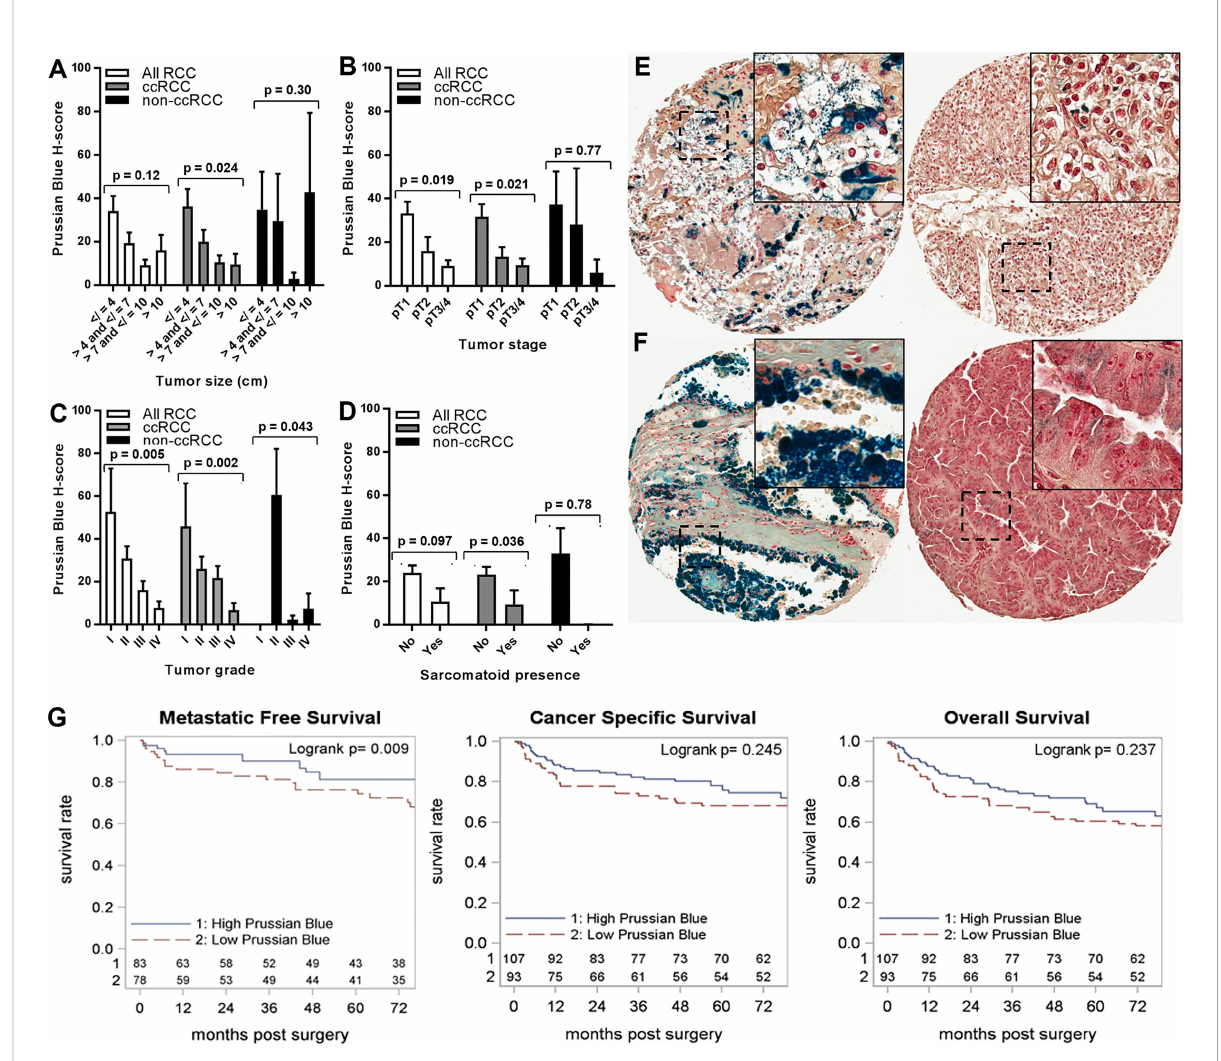
FIGURE 3 Iron levels in primary tumors decrease with tumor progression. Primary tumor iron levels (H-score) were evaluated using Prussian Blue stain of the RPCCC RCC patient TMA set and tested for association with pathologic features of primary tumors including (A) tumor size (largest diameter), (B) tumor stage, (C) tumor grade, and (D) presence of sarcomatoid dedifferentiation. Representative tissue core images are shown for low stage/grade (left) and high grade/stage (right) primary tumors of patients with (E) ccRCC and (F) pRCC. (G) Iron staining level (H-score) for the ccRCC patient subset was dichotomized at the median and tested for association with (left to right) metastatic-free survival, cancer-speci fi c survival, and overall survival using Kaplan – Meier